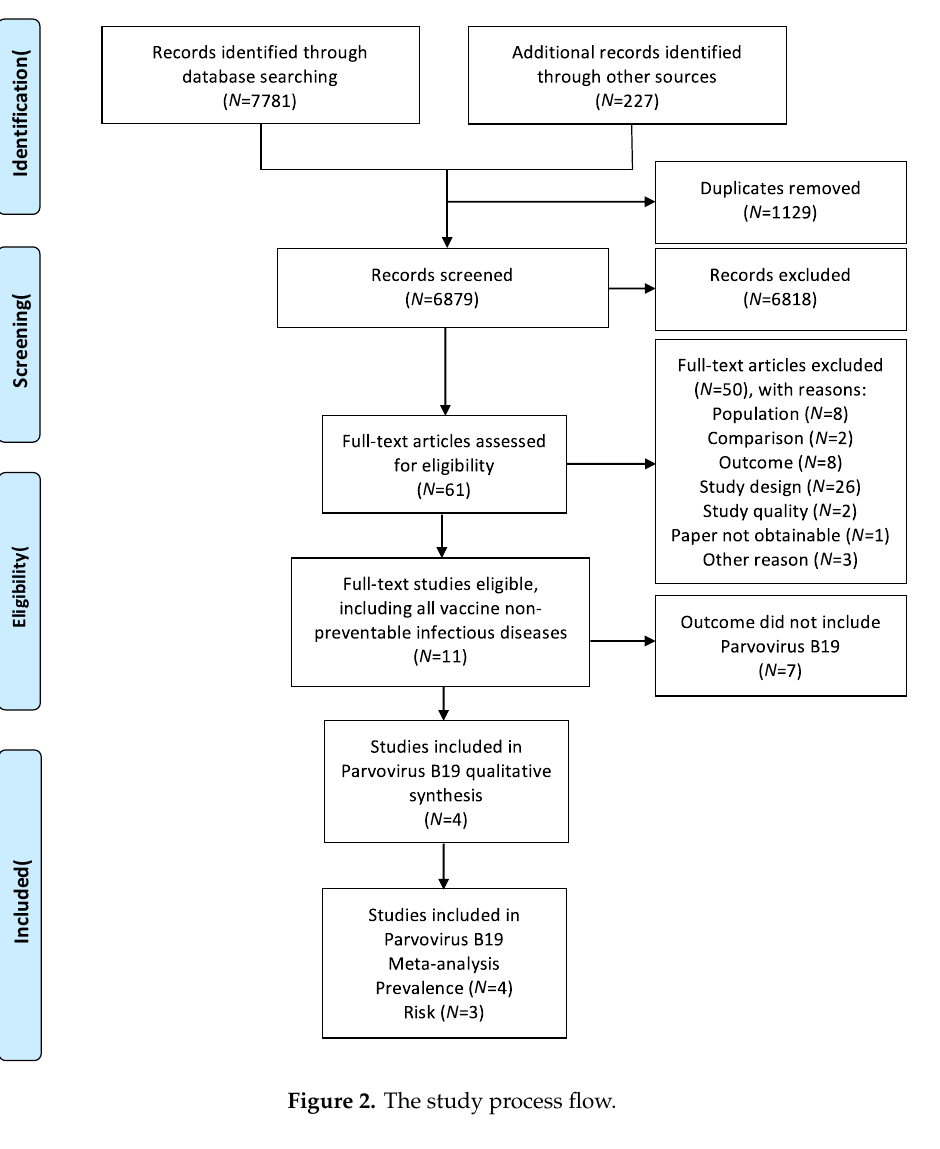
Figure 2. The study process flow.